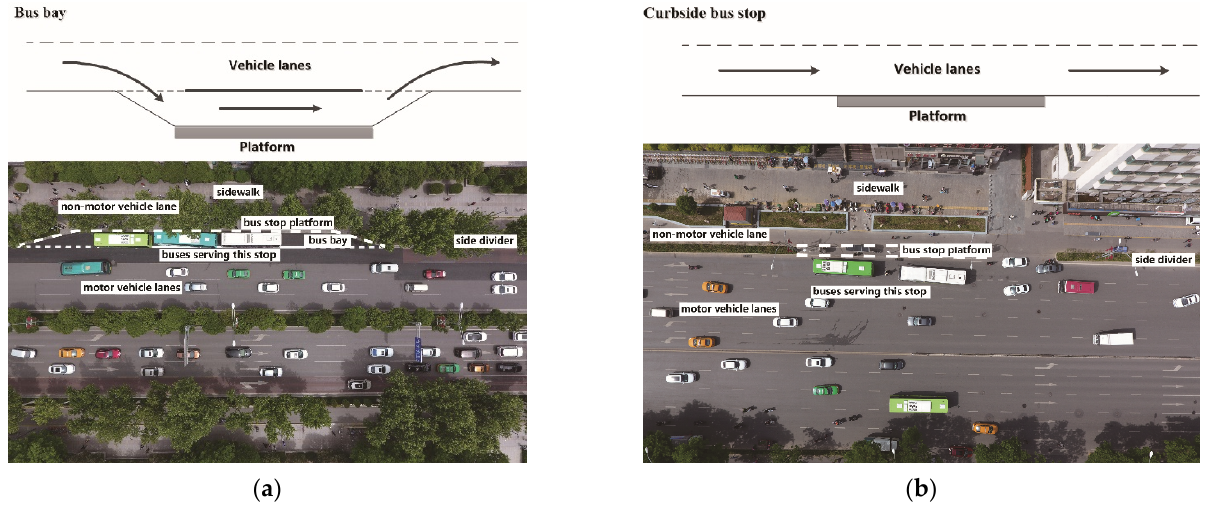
Figure 1. The two types of bus stop in this study: ( a ) bus bay stop (BBS), ( b ) curbside bus stop (CBS).